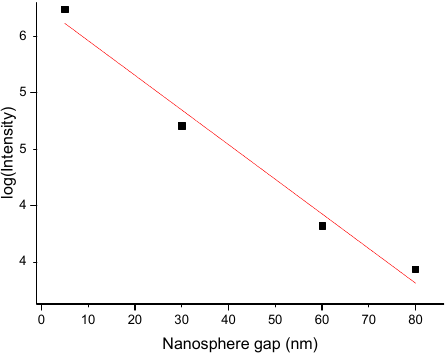
Figure 8. Intensities of the 1503 cm − 1 SERS signal of R6G recorded as a logarithmic function of the nanosphere gap size.